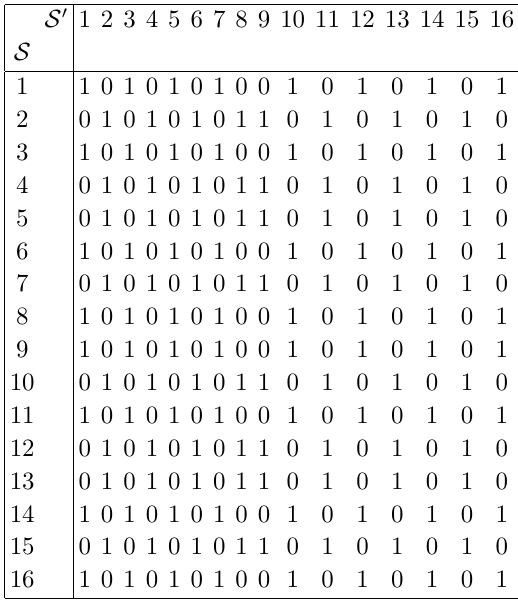
Table 27 . Gadget values for P